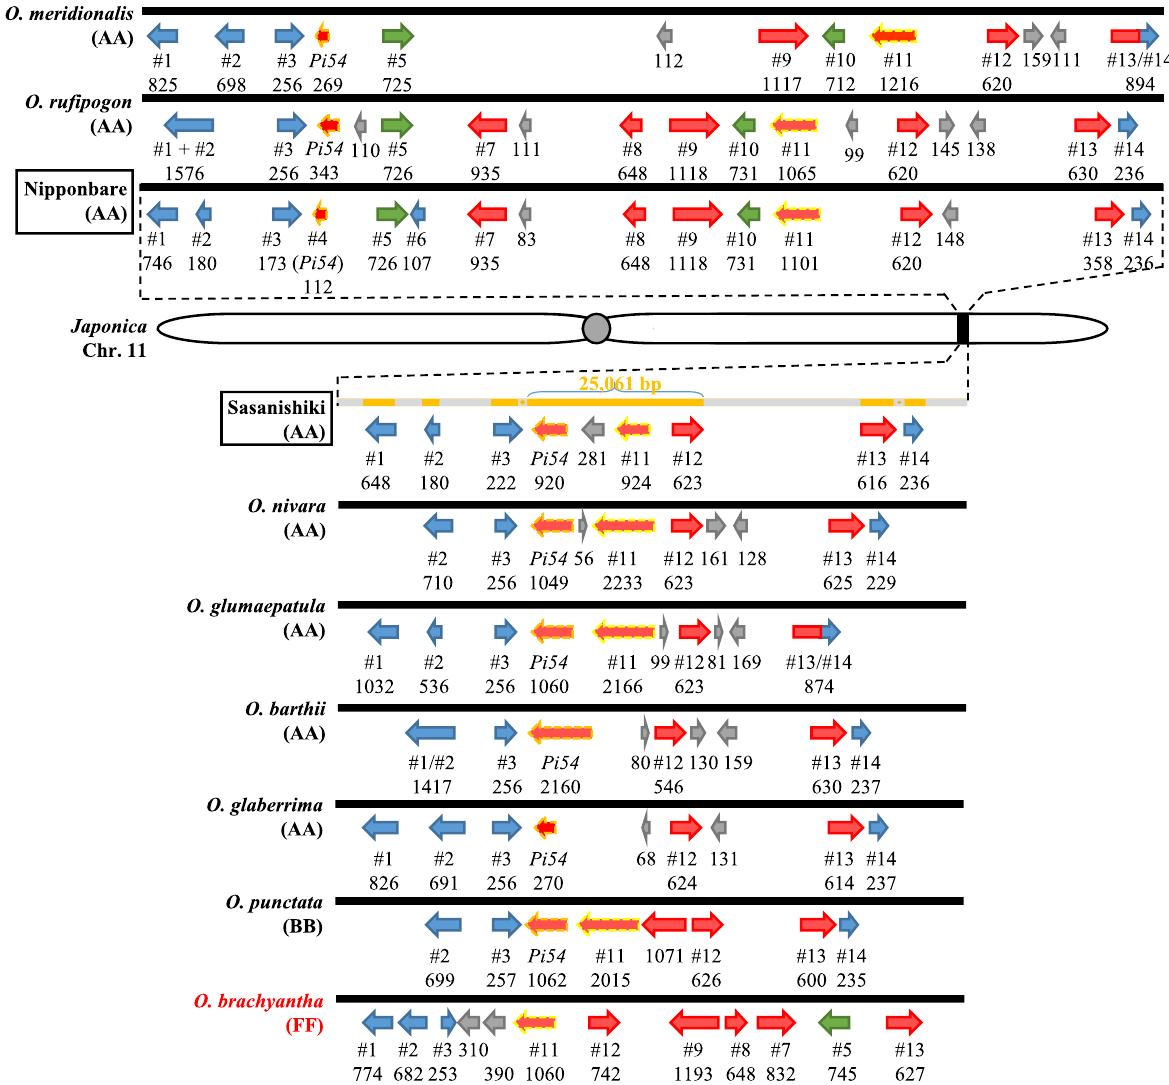
Fig. 3 Genes homologous to #1 to #14. Nipponbare: the region corresponding to 25,237,345 – 25,400,721bp on chromosome 11 of Os-Nipponbare-Reference- IRGSP-1.0. Arrows: red, NBS – LRR family-like genes; blue, miscellaneous genes; gray, presumed genes; green, translocated genes. Arrows with orange and/or yellow dashed (alleles of the Pi54 and #11, respectively) line show genes that were used to conduct phylogenetic tree. Protein size (AA) is indicated under each gene ID . Gray bars in Sasanishiki correspond to unsequenced